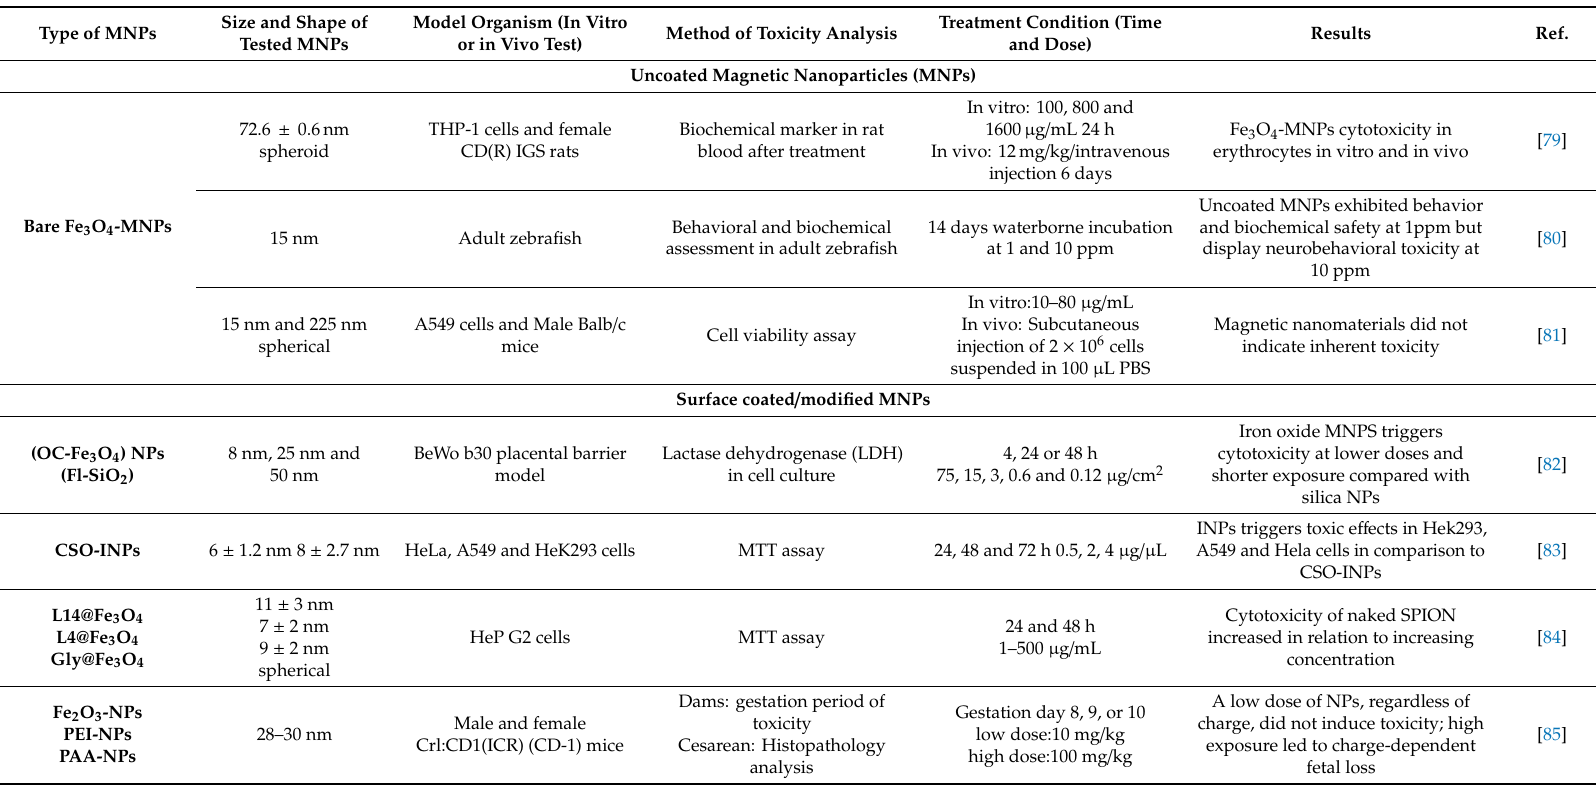
Table 1. Summary of iron oxide magnetic nanoparticle (MNPS) toxicity. Extensive amount of work is going on in area of toxicity studies of MNPs in various di ff erent combinations with appropriate enhancement with ligands, antibodies, polymeric coating, green synthesis, infusion of drug, hyperthermia application and external magnetic control with retention in superparamagnetism to be able to detect and direct MNPs at desired location. With many papers coming up each year in the field we have compiled a list of papers from year 2015–2019 to indicated the di ff erent types of (iron oxide) MNPs used in di ff erent kind of models recently to study the toxicological response of these